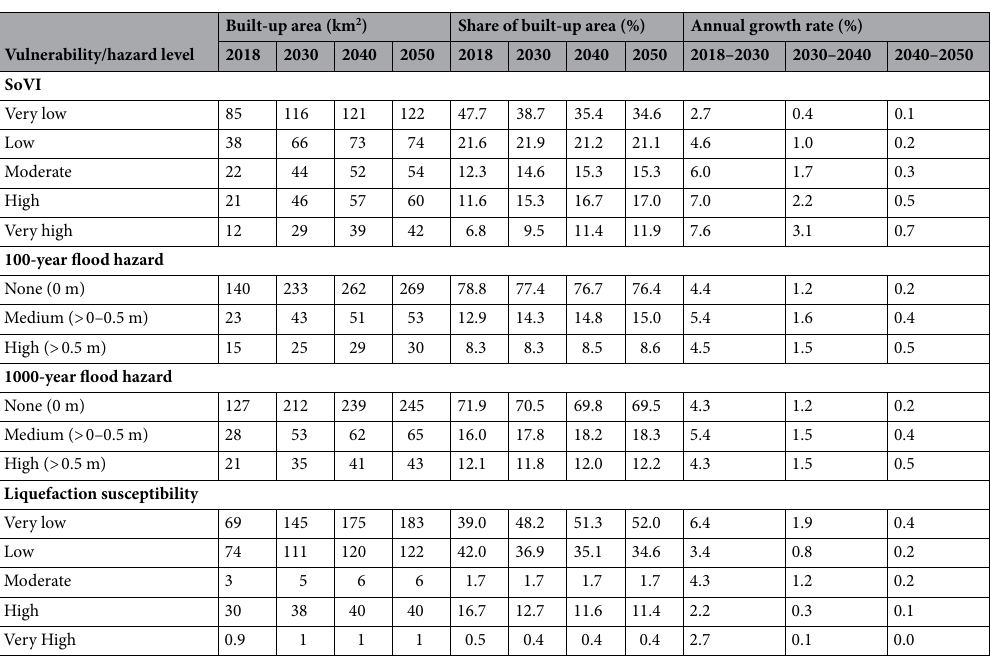
Table 4. Changes in built-up areas disaggregated by SoVI category, flood hazard depth range, and